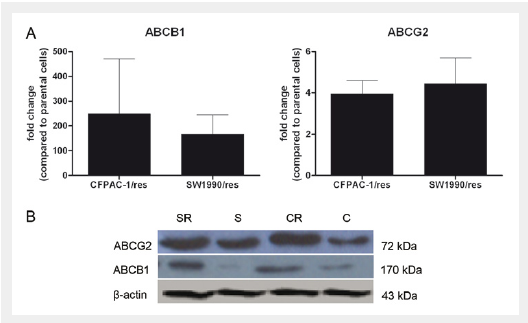
Gemcitabine-resistant pancreatic cancer cells highly express ABCB1 and ABCG2. A. Quantitative RT-PCR was used to evaluate the relative expression level of ABCB1 and ABCG2 gene expression in gemcitabine-resistant cells when compared to their parental cells. Fold change was analysed by the 2 – ΔΔ Ct method, while the expression of β-actin was used to normalise the relative expression of each gene within each cell line. B. The results of the western blot analysis were consistent with the mRNA expression. Values represent mean ± S.D. of three independent experiments.